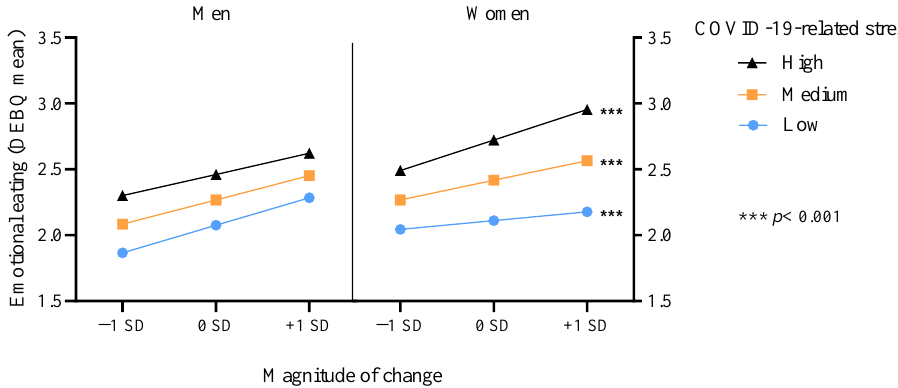
Figure 2. Moderating effect of COVID-19-related stress and gender on the relationship between the magnitude of change and emotional eating.